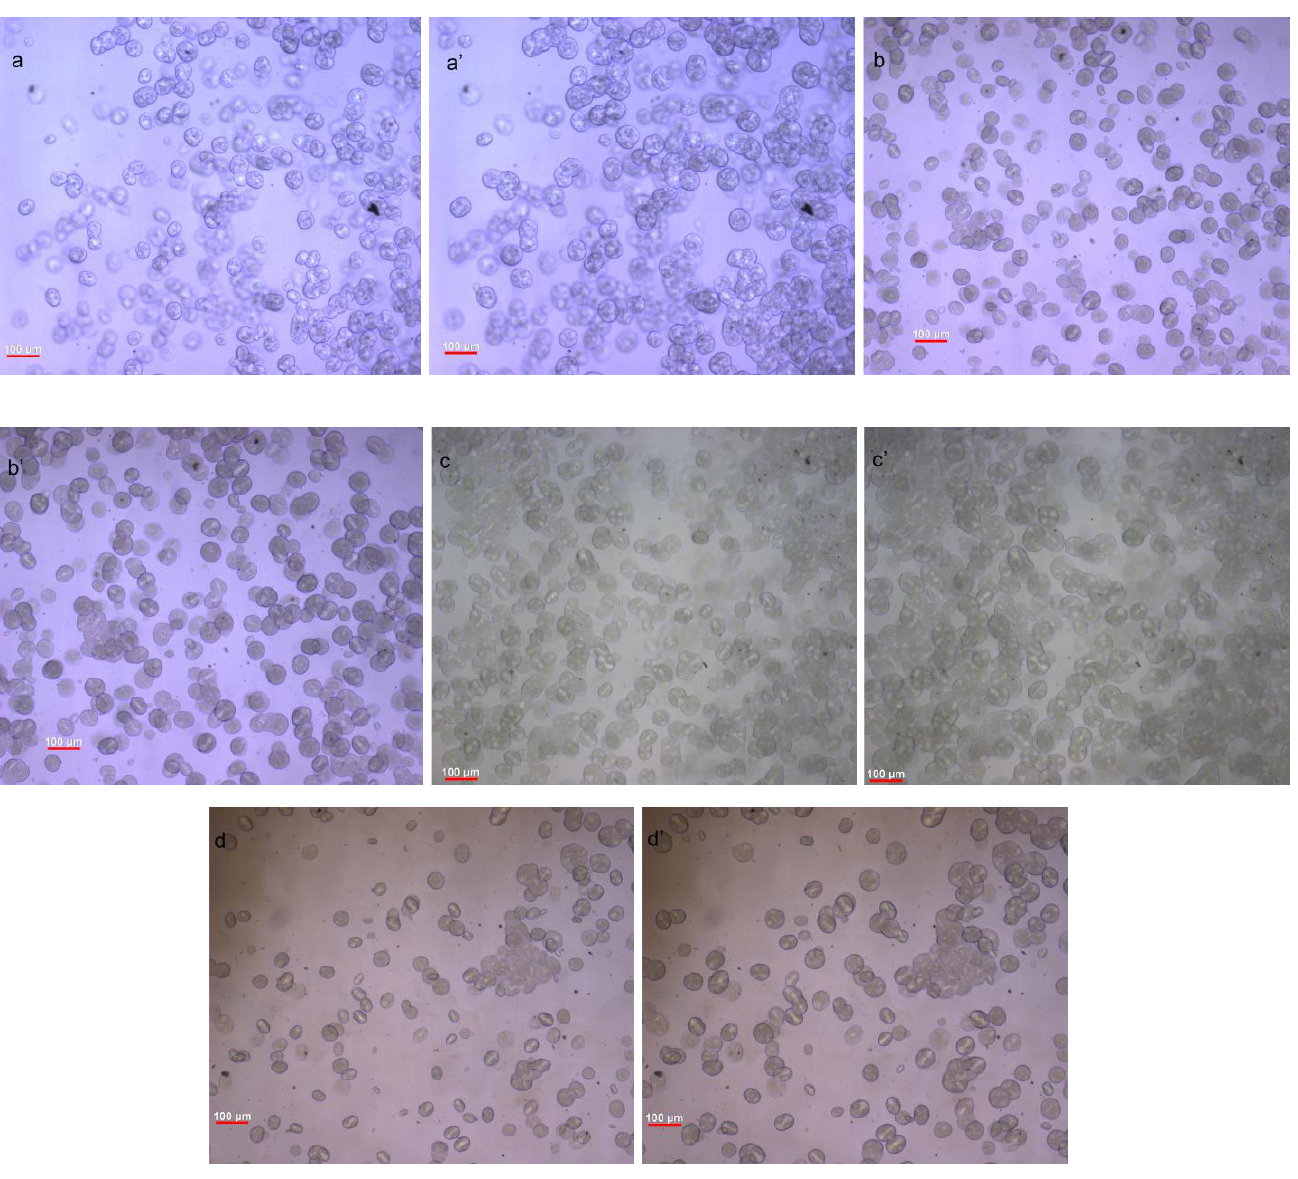
Figure 8. POM microscopies of PPgMA and LIonomers as a function of annealing time at 120 °C (scale bar 100 µ m): PPgMA ( a ) 80 s, ( a’ ) 100 s; L-P + DEP-10 ( b ) 80 s, ( b’ ) 100 s; L-EMIM DEP-10 ( c ) 70 s, ( c’ ) 90 s; L-EMIM Ac-10 ( d ) 100 s, ( d’ ) 120 s.